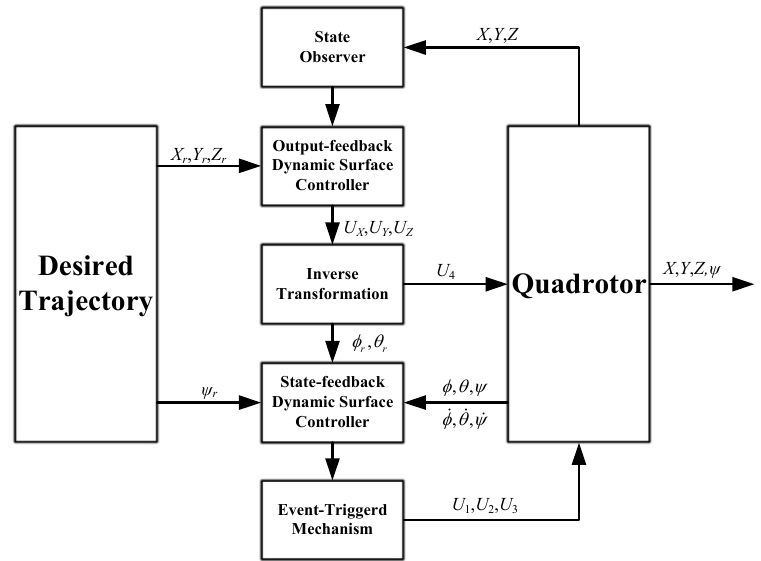
Figure 2. The architecture of the proposed control